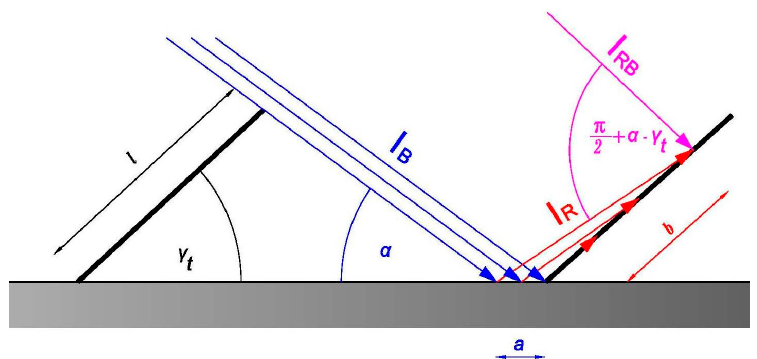
Figure 10. The calculation of a direct reflected component.